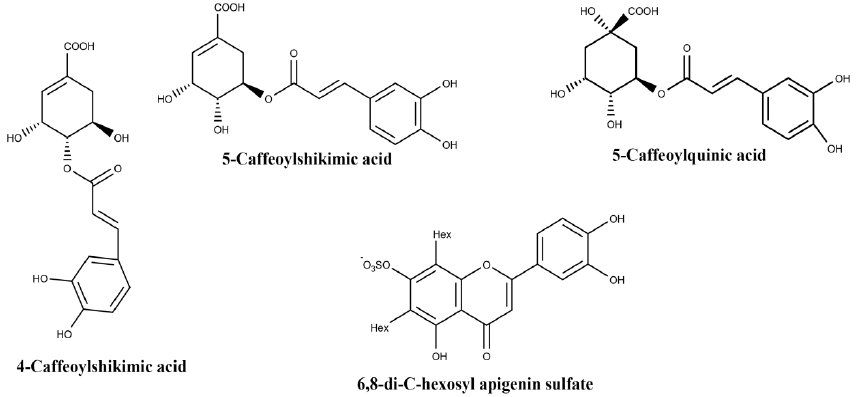
Figure 3. Structures of the main components of Euterpe oleracea Mart. root and leaf; Hex: hexose.